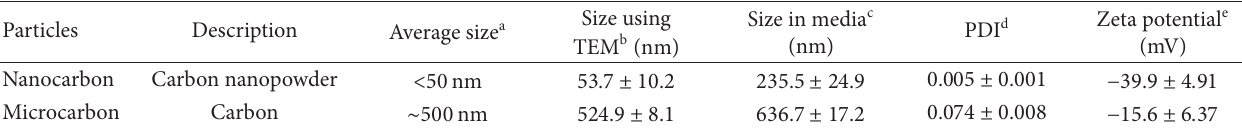
Table 2: Particle